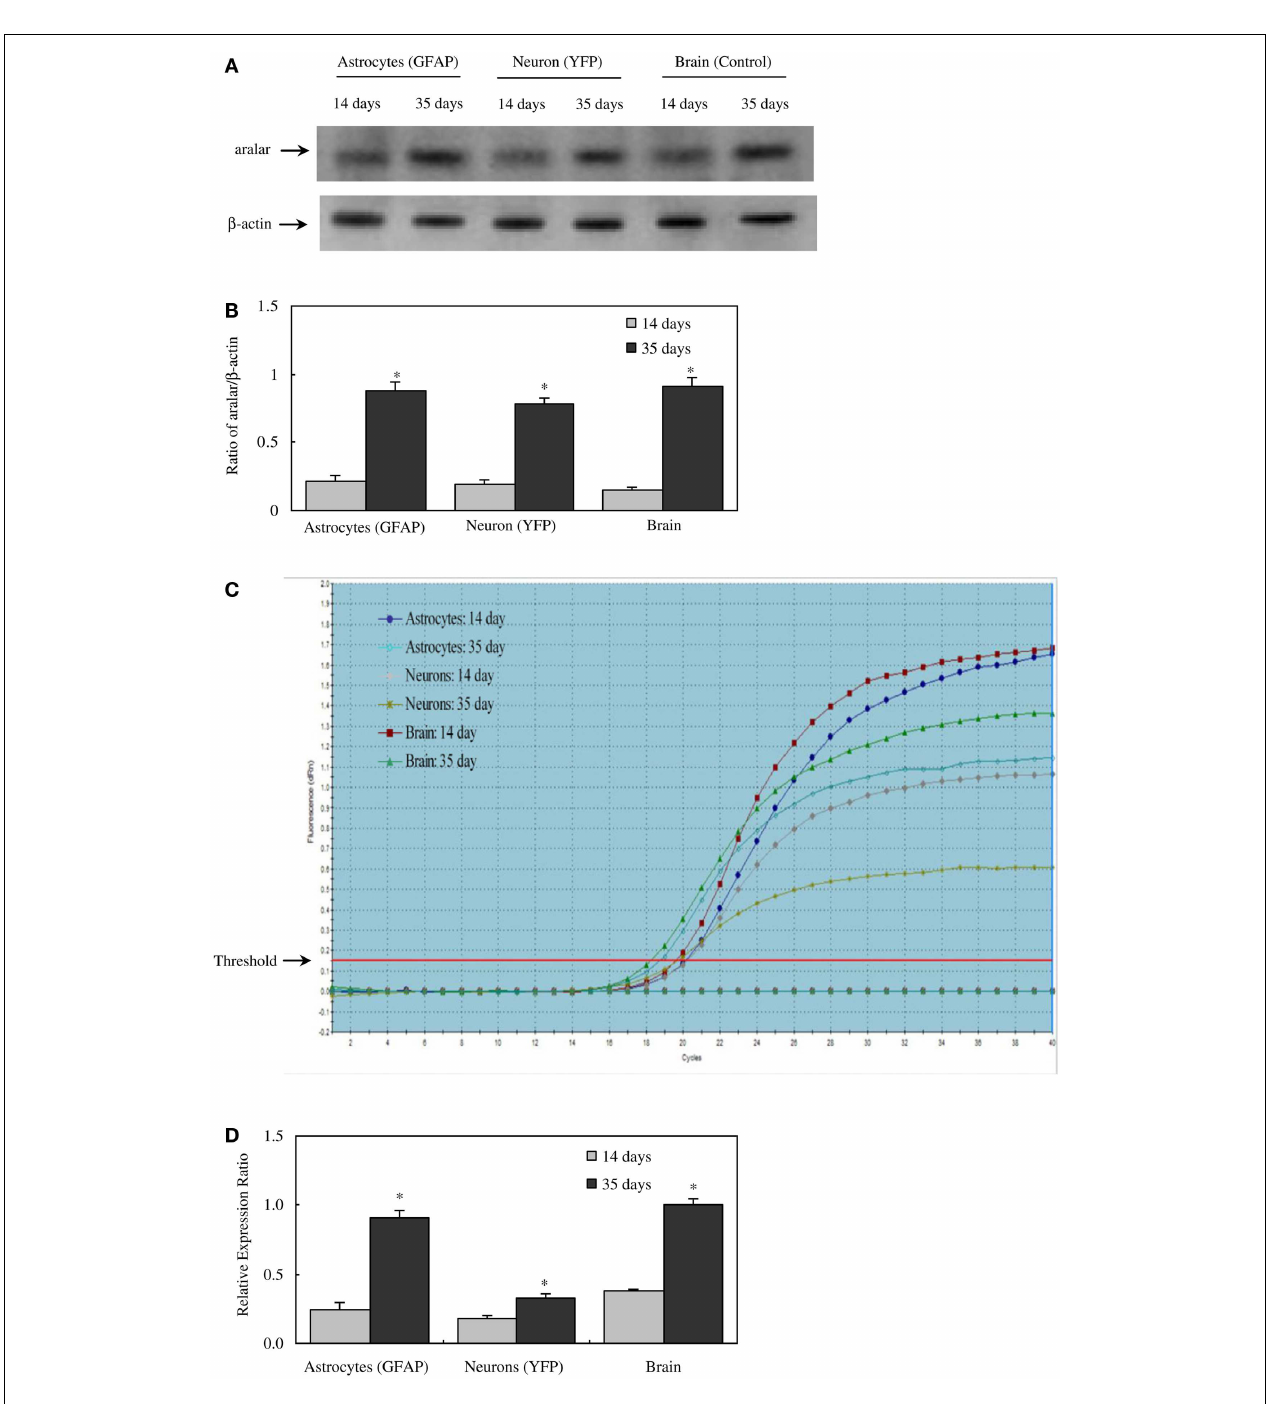
between aralar and β -actin. *Statistically significant ( P < 0.05) difference from the same preparation from 14-day-old animals. (C) A representative amplification plot of aralar mRNA expression, determined by real-time PCR. Similar results were obtained from three independent experiments. For analysis of graph, see Xu et al., under revision. (D) Means ± SEM ( n = 3) of the relative expression ratio of aralar. *Statistically significant ( P < 0.05) difference from the same preparation from 14-day-old animals. From